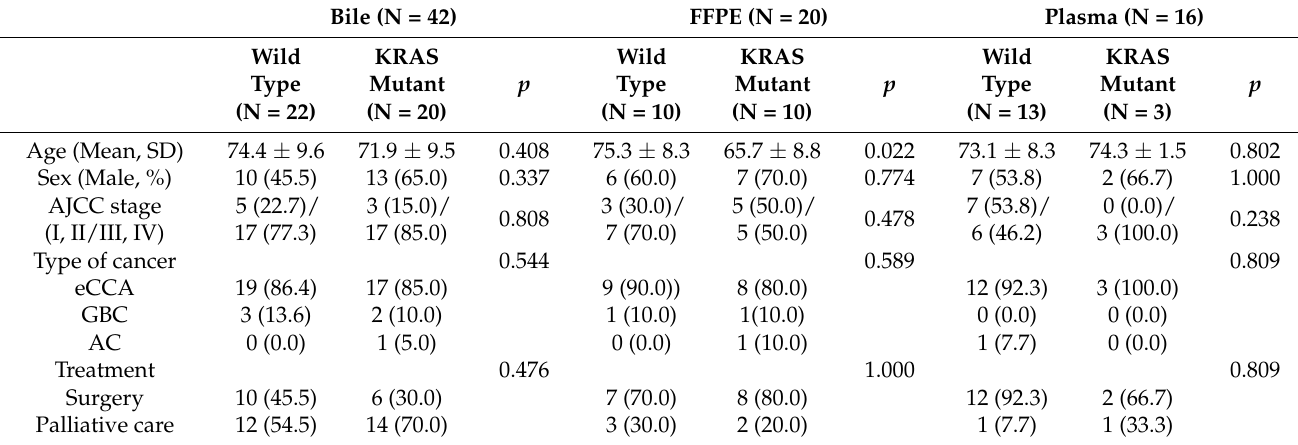
Table 1. Clinical characteristics of patients according to the bile, FFPE, and plasma samples analyzed.